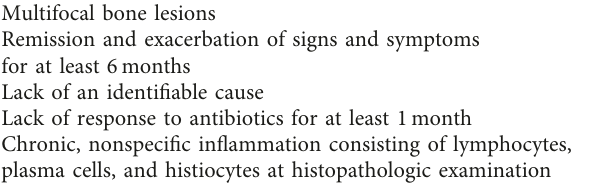
Table 3: Proposed criteria for CRMO